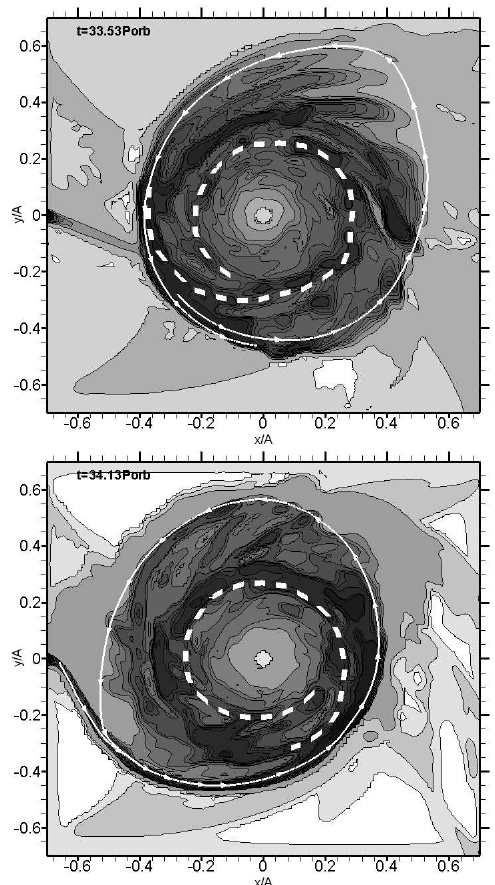
Figure 1: Density distributions in the equatorial plane of the system for two time moments τ = 33 . 53 P orb (top panel) and τ = 34 . 13 P orb (bottom panel). The white dashed line denotes the position of the precessional den- sity